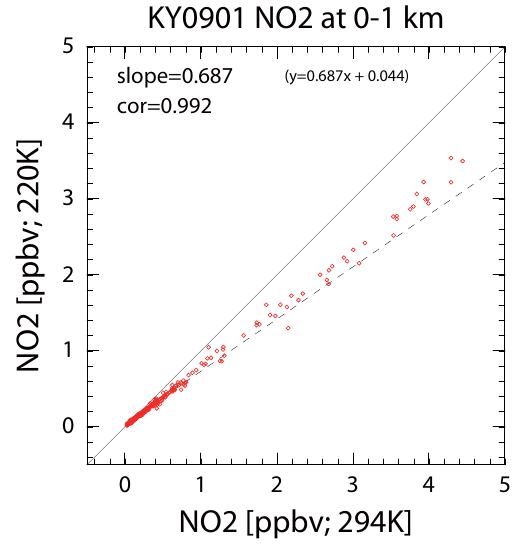
Fig. 9. Scatter plot of NO 2 concentrations for cross-sections at 294 and 220K during cruise KY0901. Solid and dashed lines represent the 1 : 1 relationship and the linear least-squares fit,